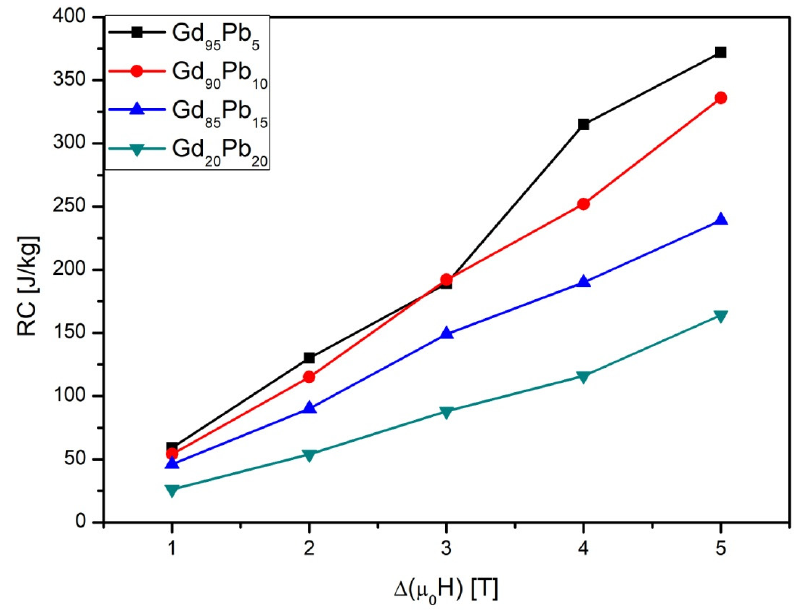
Figure 6. Magnetic field dependencies of refrigeration capacity of the investigated samples.